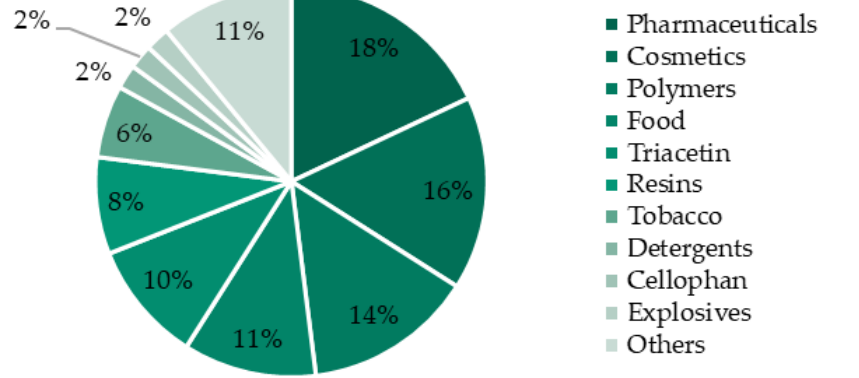
Figure 1. The main glycerol applications.